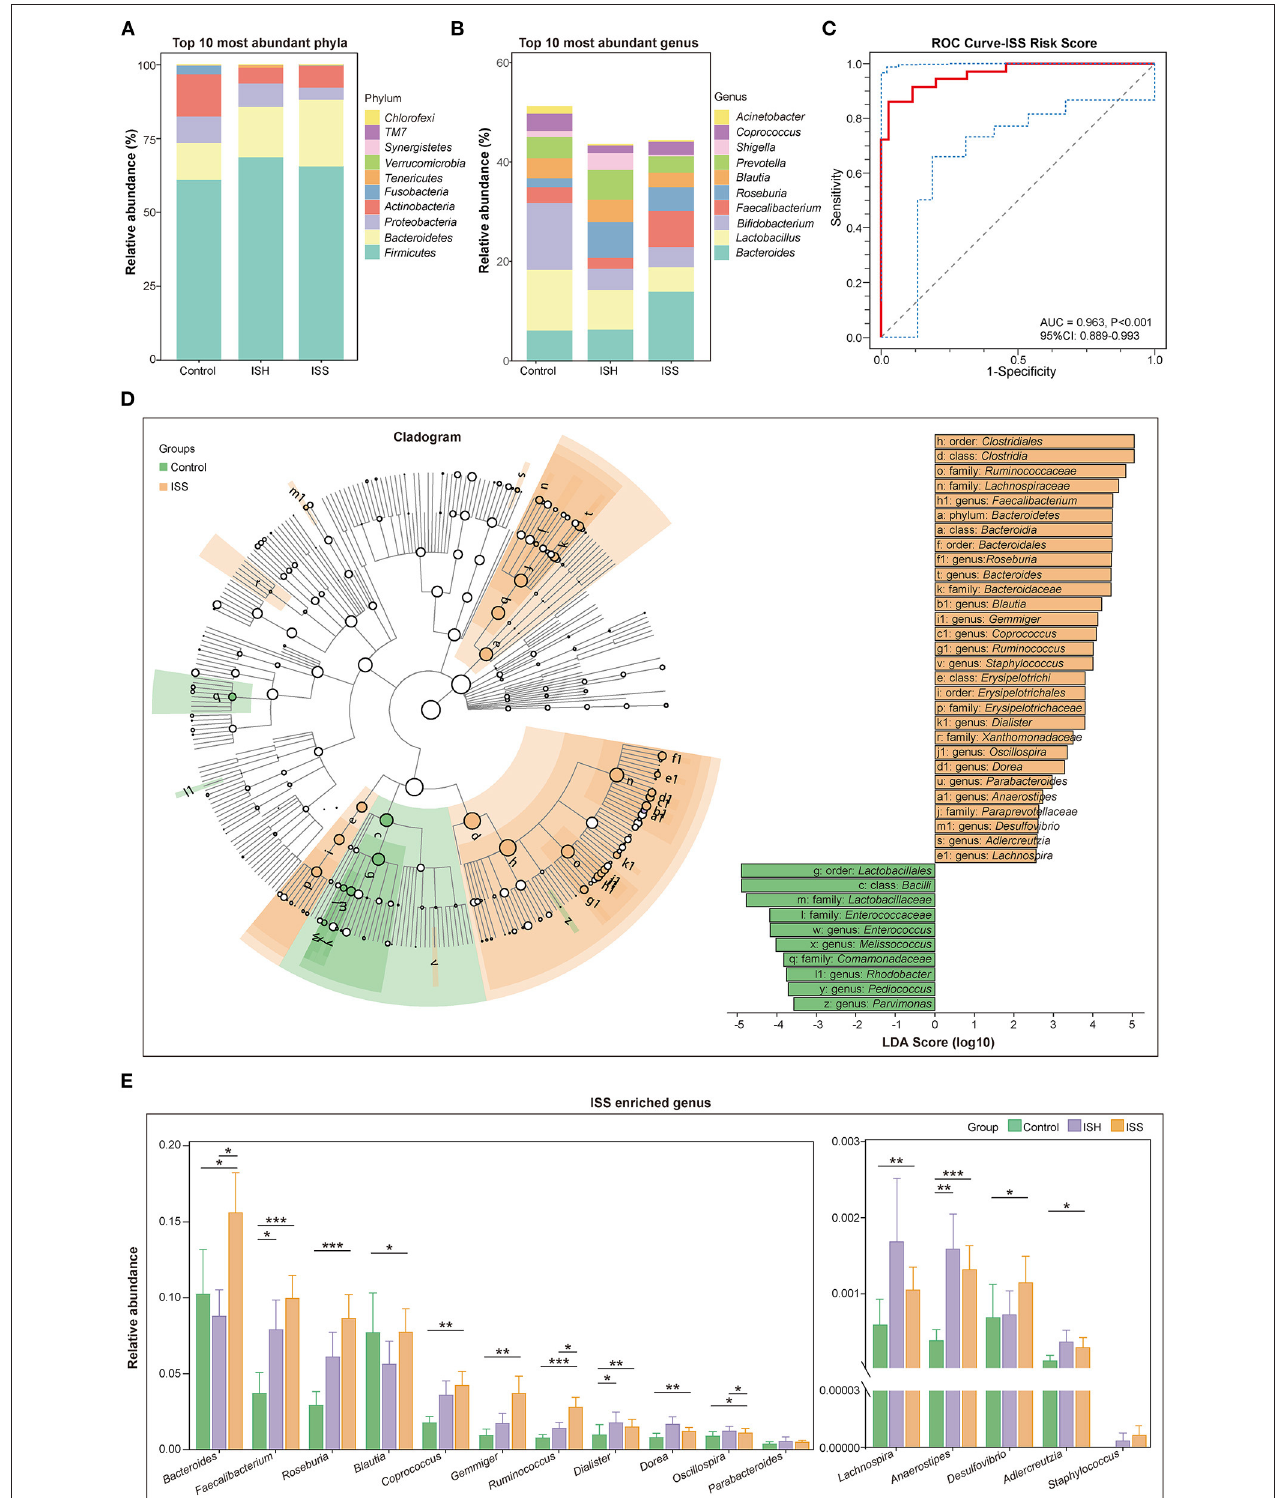
FIGURE 2 | Distinct difference in gut microbiota in the CAD patients with in-stent patency, hyperplasia, and stenosis. (A) Bar plot of relative abundance of the top 10 most abundant phyla in the control, ISH, and ISS groups. (B) Bar plot of relative abundance of the top 10 most abundant genera in the control, ISH, and ISS